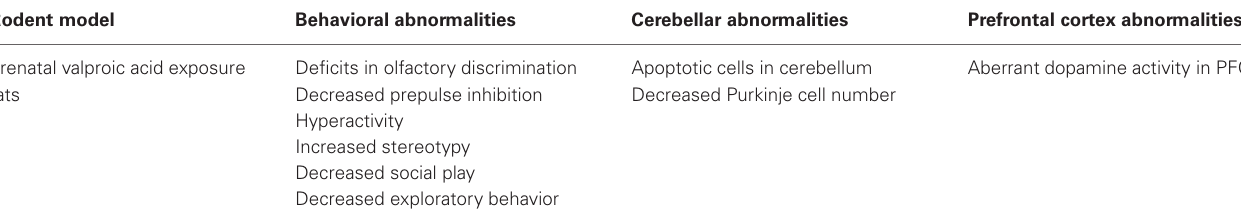
Table 3 | Summary of toxic exposure rodent model with cerebellar and behavioral abnormalities that parallel those observed in autism. Rodent